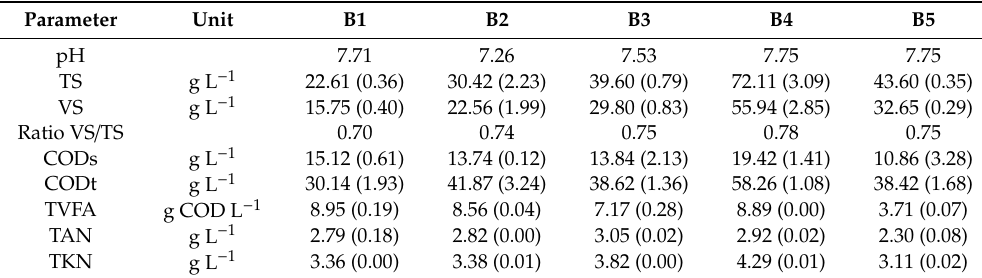
Figure 2. Pictures of the pilot plant. Shipping container, where the mobile pilot plant is located ( A ), manure tank with 16 membrane parallel panels ( B,C ), membrane panel ( D ), open pipeline for trapping solution collection ( E ), trapping solution tank ( F ). Table 1. Chemical characterization for swine manure in the di ff erent batch experiments from B1 to B5. Average (SD) for duplicated analyses are